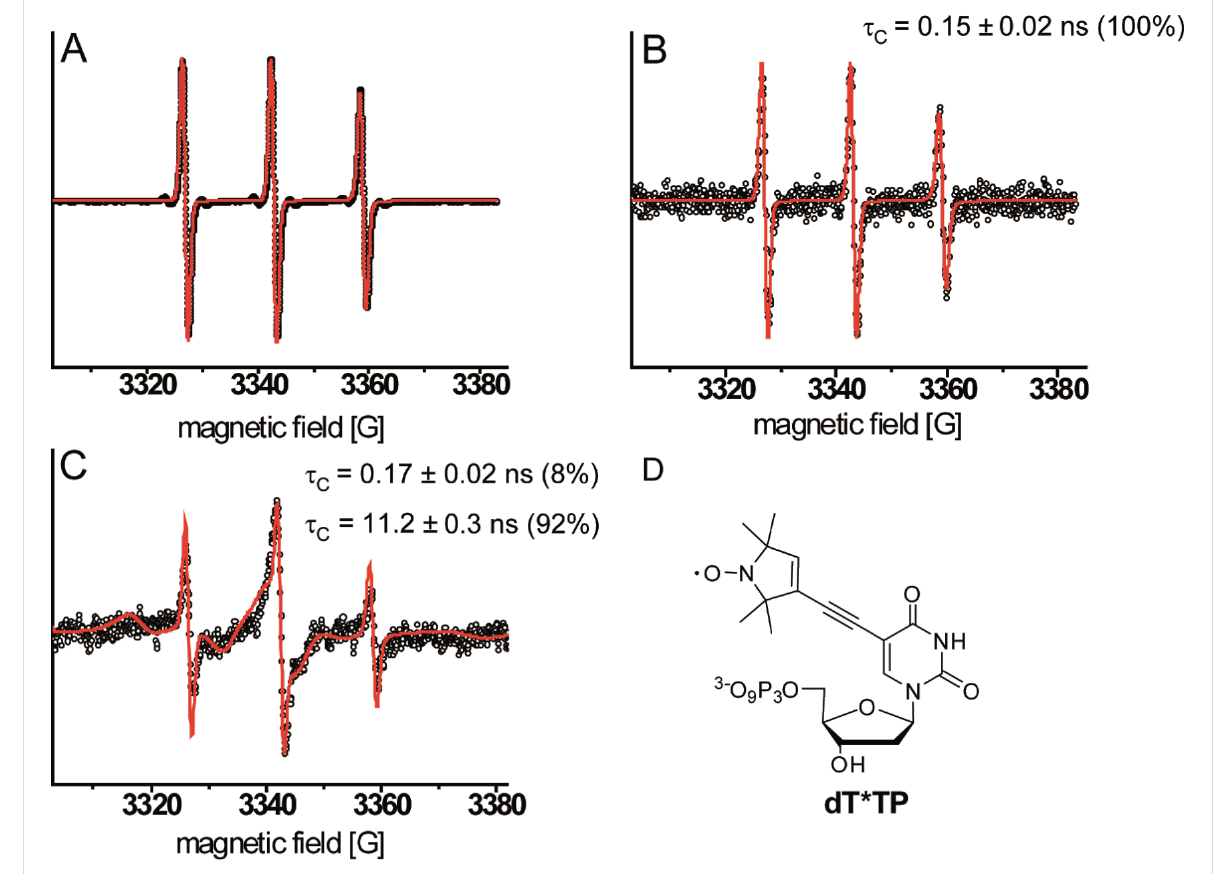
Figure 5: EPR spectra with corresponding spectral simulations (red line) of (A) dT*TP, (B) PCR reaction product resulting from non-branched primers in the presence of 50% dT*TP; The simulated spectrum and the corresponding τ C are derived from a one component fit, (C) DNA networks generated by PCR in the presence of 50% dTTP* using branched primer; the simulated spectrum and corresponding τ C are derived from a two component fit, (D) structure of modified dT*TP employed in